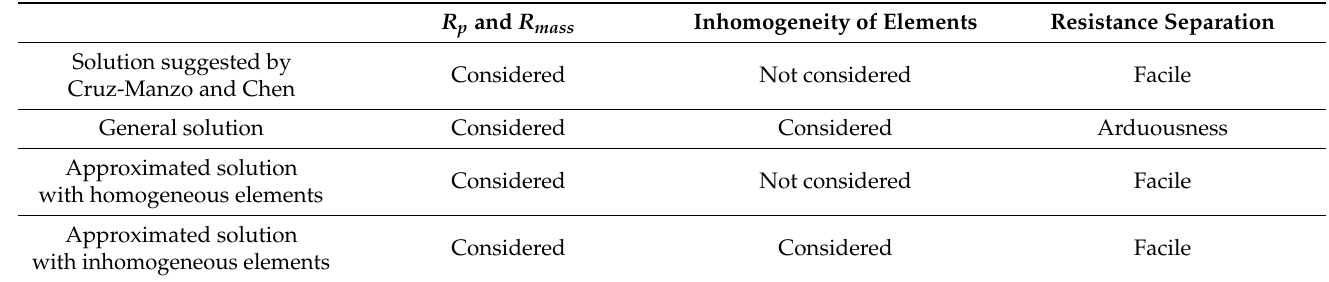
Table 3. Summary of solutions.